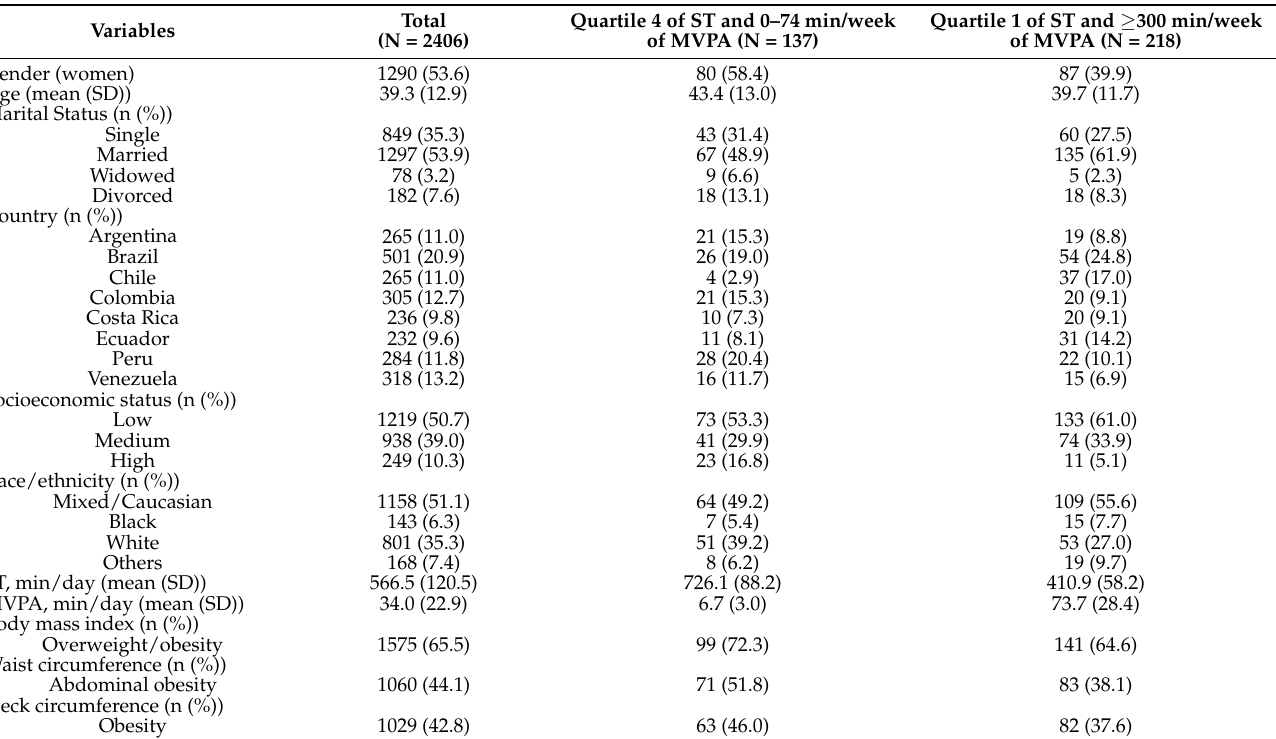
Table 1. Descriptive analysis (mean (SD) and frequency (%)) of demographic, behavioral, and health status